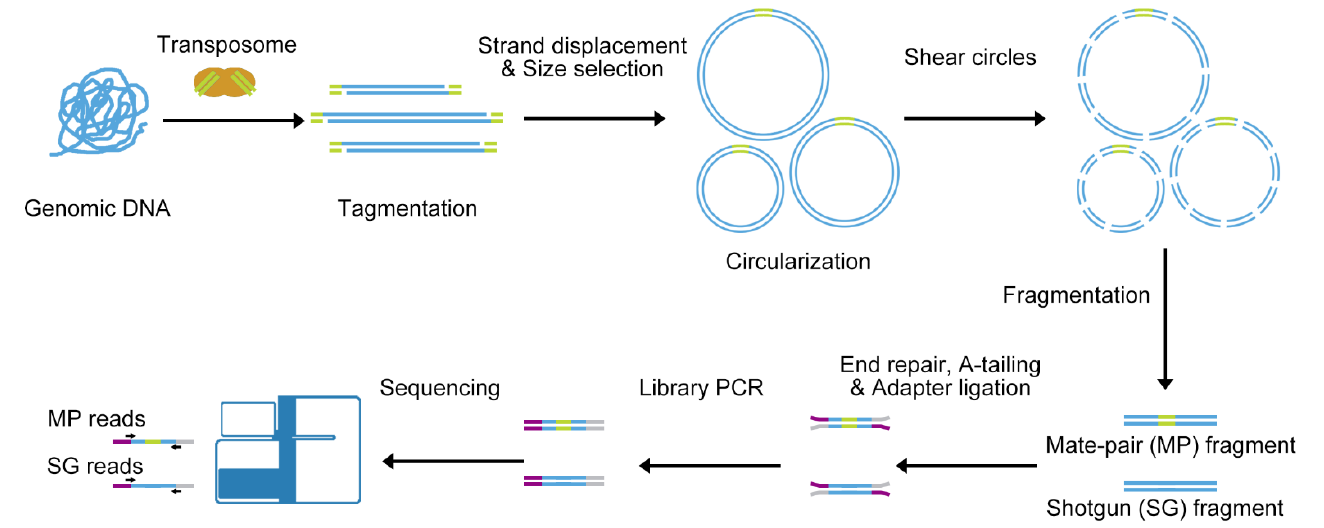
Figure 1. All-seq overview. Genomic DNA fragments are indicated in blue, Tn5 adapter sequence in green, P5 adapter in purple, and P7 adapter in gray. MP for Mate-pair reads and SG for Shotgun reads.